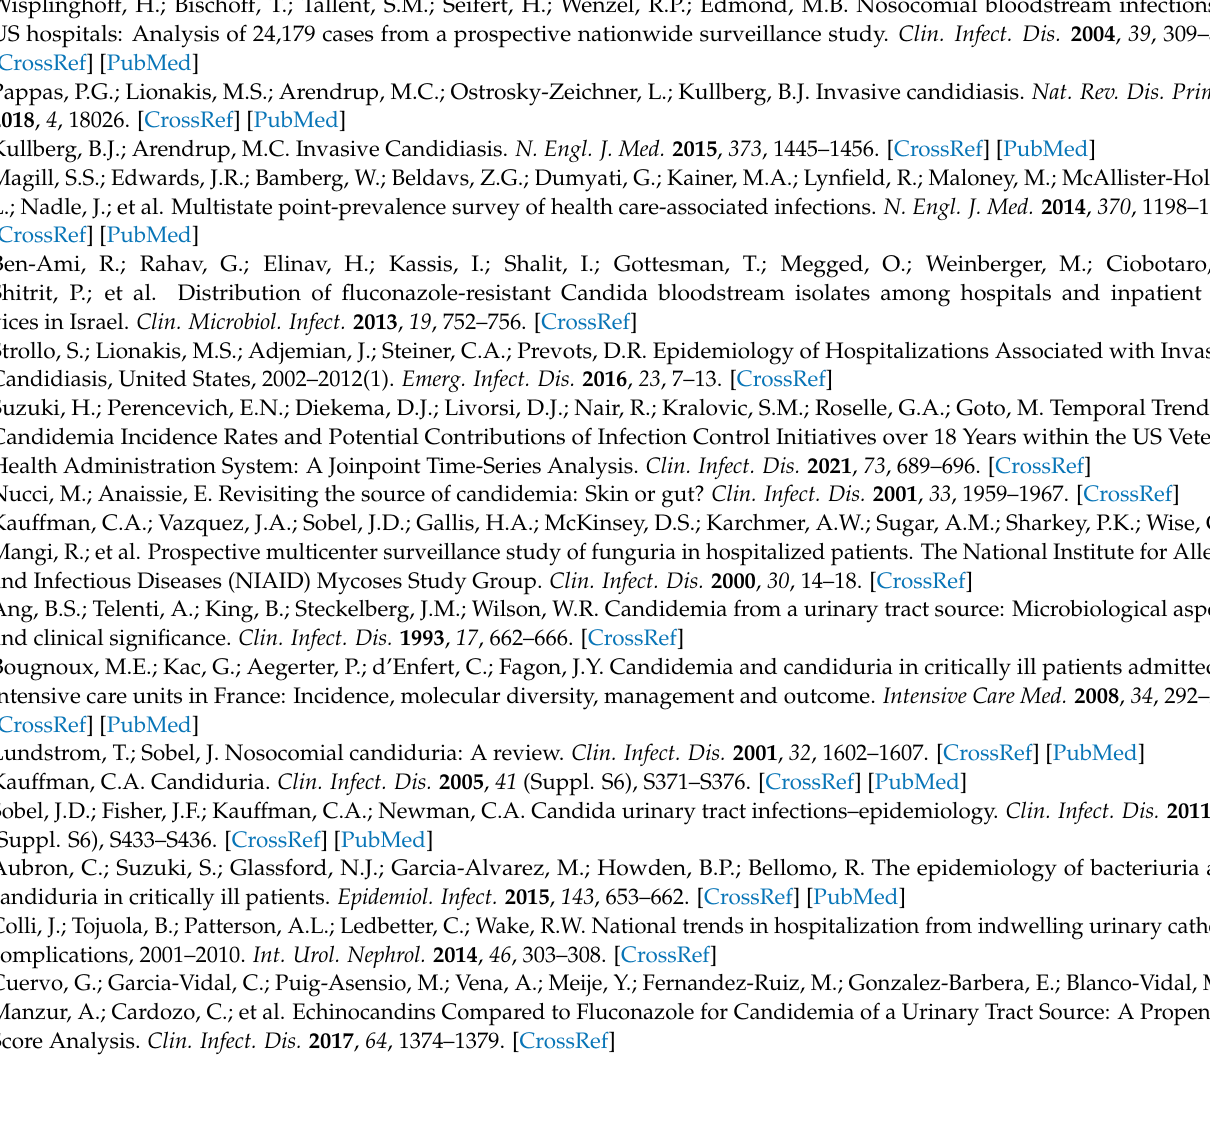
Table S2: Clinical features of patients with urinary-origin Candida bloodstream